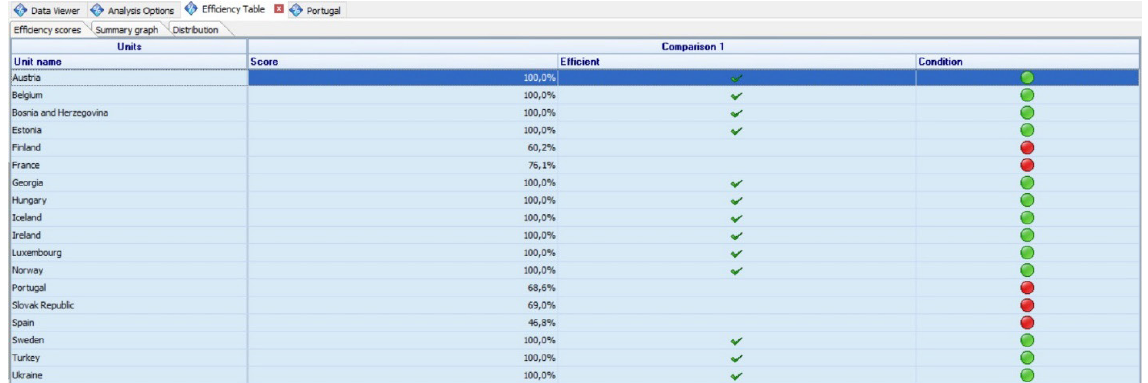
Figure 4. Functioning efficiency of banking systems of 17 European countries and Ukraine as of 2020, calculated using the DEA BCC